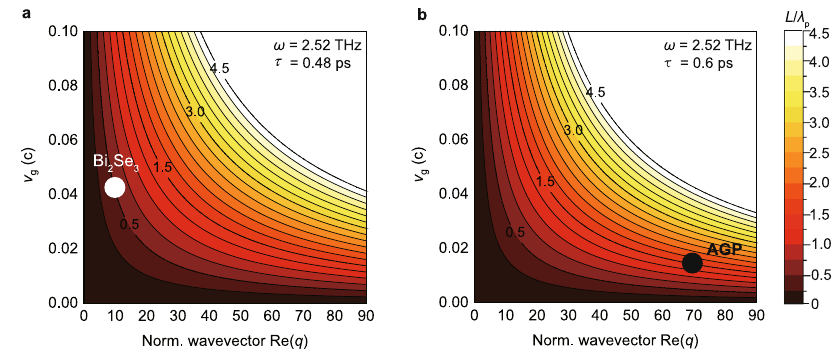
Fig. 5 Relative propagation length L/ λ p of 2.52 THz polaritons as a function of wavevector and group velocity. a Polariton amplitude decay time is τ = 0.48 ps. Black numbers indicate the relative propagation lengths. White symbol shows experimental relative propagation length for THz polaritons in the 25-nm-thick Bi 2 Se 3 . b Polariton amplitude decay time is τ = 0.6 ps. Black numbers indicate the relative propagation length. Black symbol shows the experimental relative propagation length of acoustic graphene plasmon (AGP) of an amplitude decay time of 0.6 ps in high-quality graphene encapsulated in h-BN (data taken from Alonso-Gonzalez et al.